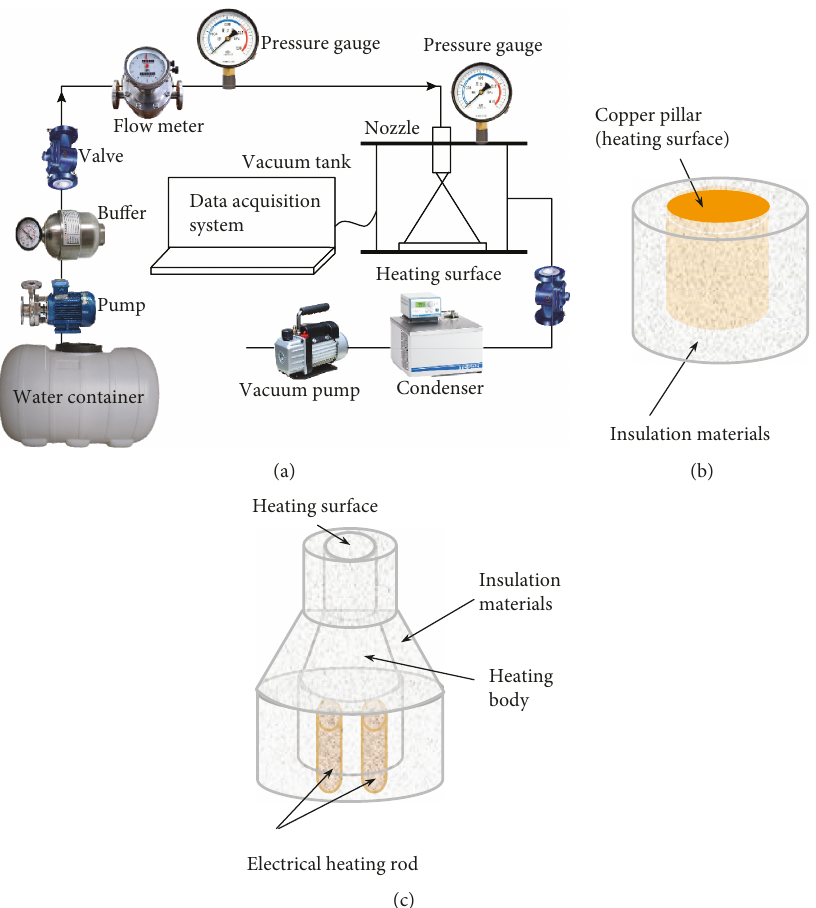
Figure 8: (a) Experimental system of the vacuum fl ash evaporation spray cooling [27]. (b) Heating system on the heating surface. (c) The improved heating system on the heating